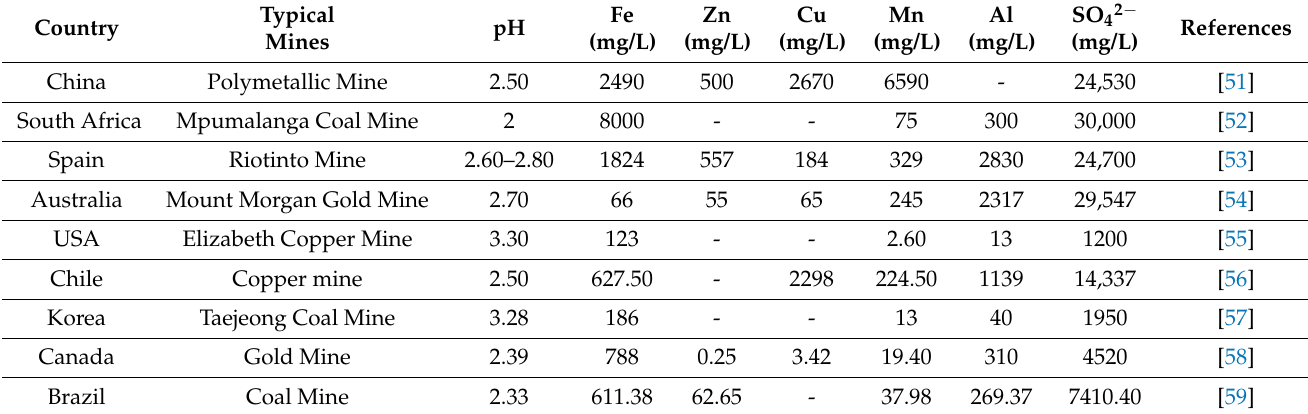
Table 1. Chemical components of acid mine drainage from typical mines across the world.